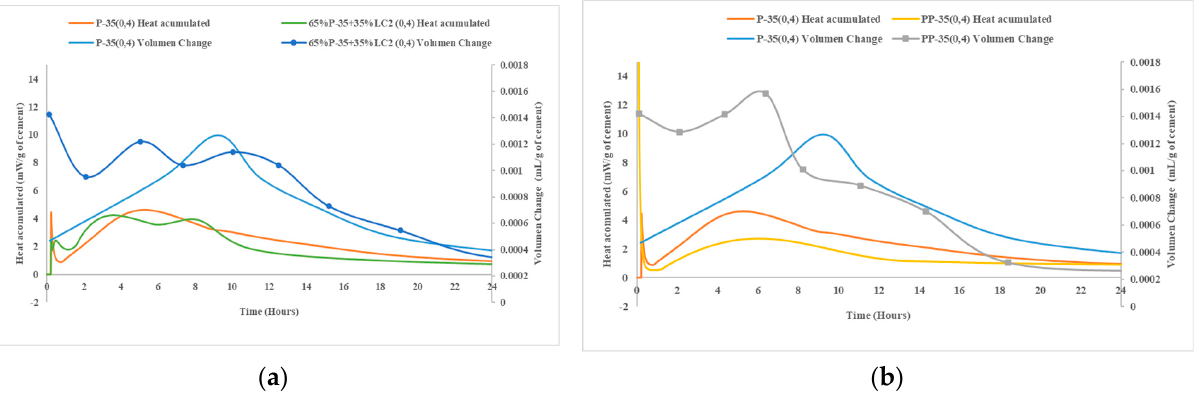
Figure 4. Impact of cement type on hydration in cementitious systems. ( a ) LC3 binder, ( b ) Pozzolanic cement containing 15% of natural pozzolan binder.